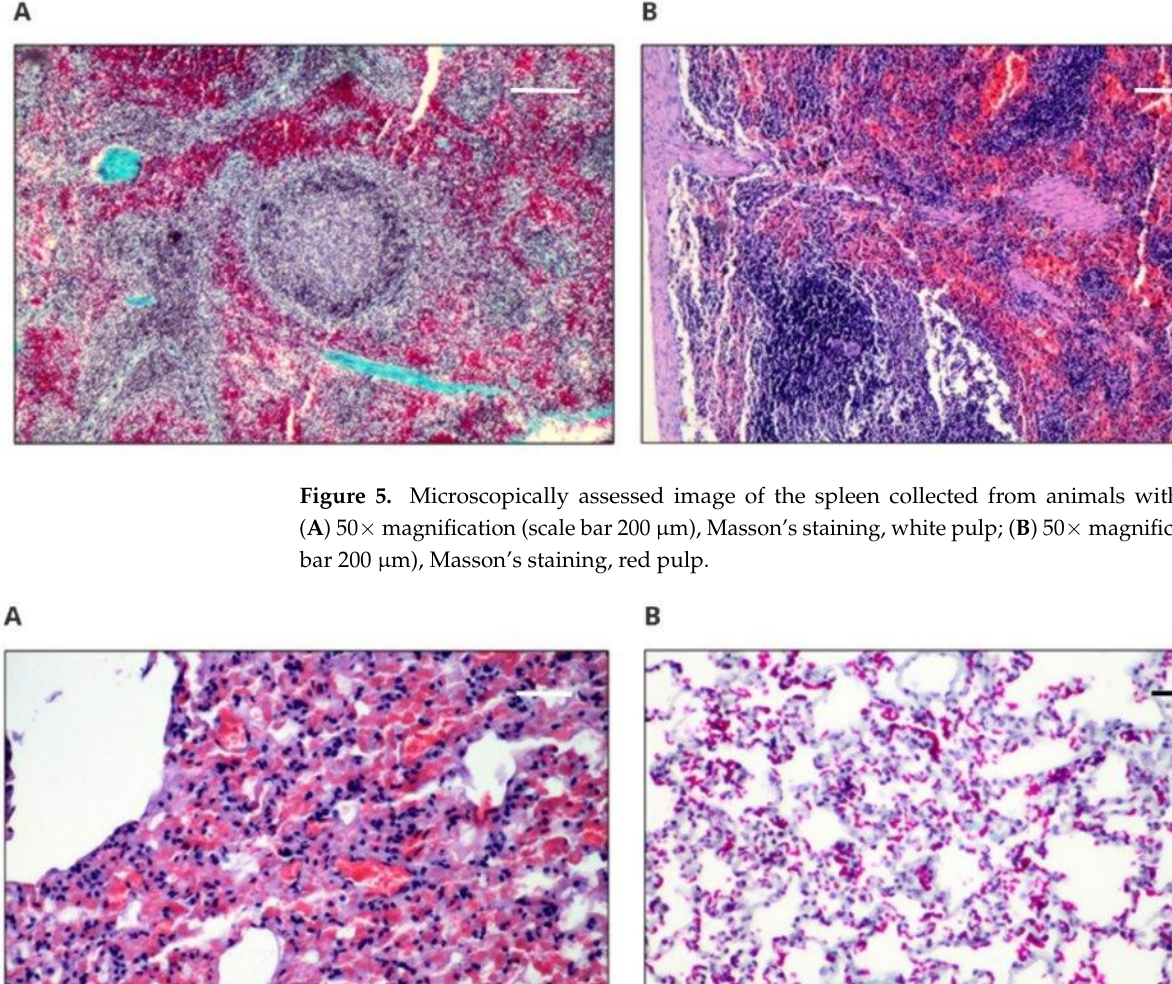
Figure 7. Microscopically assessed image of kidney collected from animals with implants: ( A ) 100× magnification (scale bar 100 µm), hematoxylin–eosin staining, typical coil, and coil structure; ( B ) 50× magnification (scale bar 100 µm), Masson’s staining, typical coil and lobe structure; ( C ) 100× mag- nification (scale bar 100 µm), hematoxylin–eosin staining, renal pelvic transitional epithelium. 3.4. The Results of the FTIR and GPC The last stage of our work was the assessment of the chemical stability of the material in the environment of the living tissues of the rabbit body—after intramuscular implanta- tion. FTIR and GPC were used to test the biomaterial samples recovered after implanta- tion. The in vivo impact studies on the polishes were carried out for a 12-week observation period. FTIR analysis showed that the tested material samples were homogeneous; no changes were observed in the FT IR spectra made during four measurements for each sample. The FTIR ATR spectra show characteristic adsorption bands: for materials PET/DLA. Absorption spectrum in the region of 2800–2950 cm − 1 corresponds to the